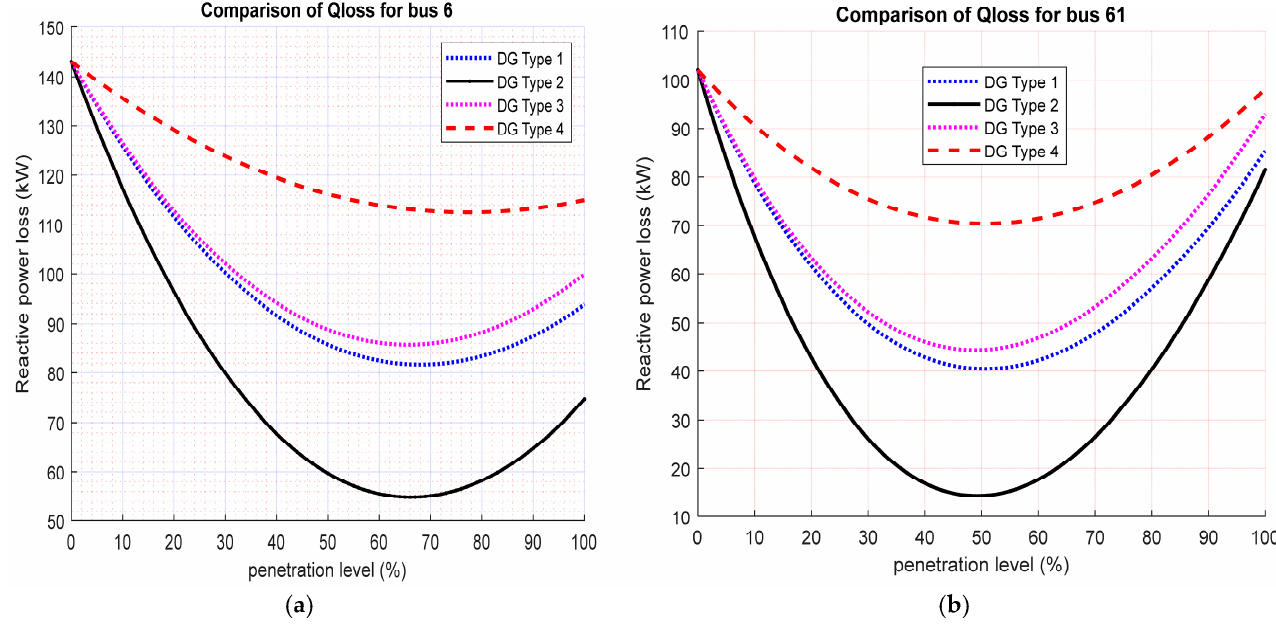
Figure 26. Comparison of reactive power loss by different DG types interconnected to ( a ) bus 6 of IEEE 33-bus and ( b ) bus 61 of the IEEE 69-bus RDNs.